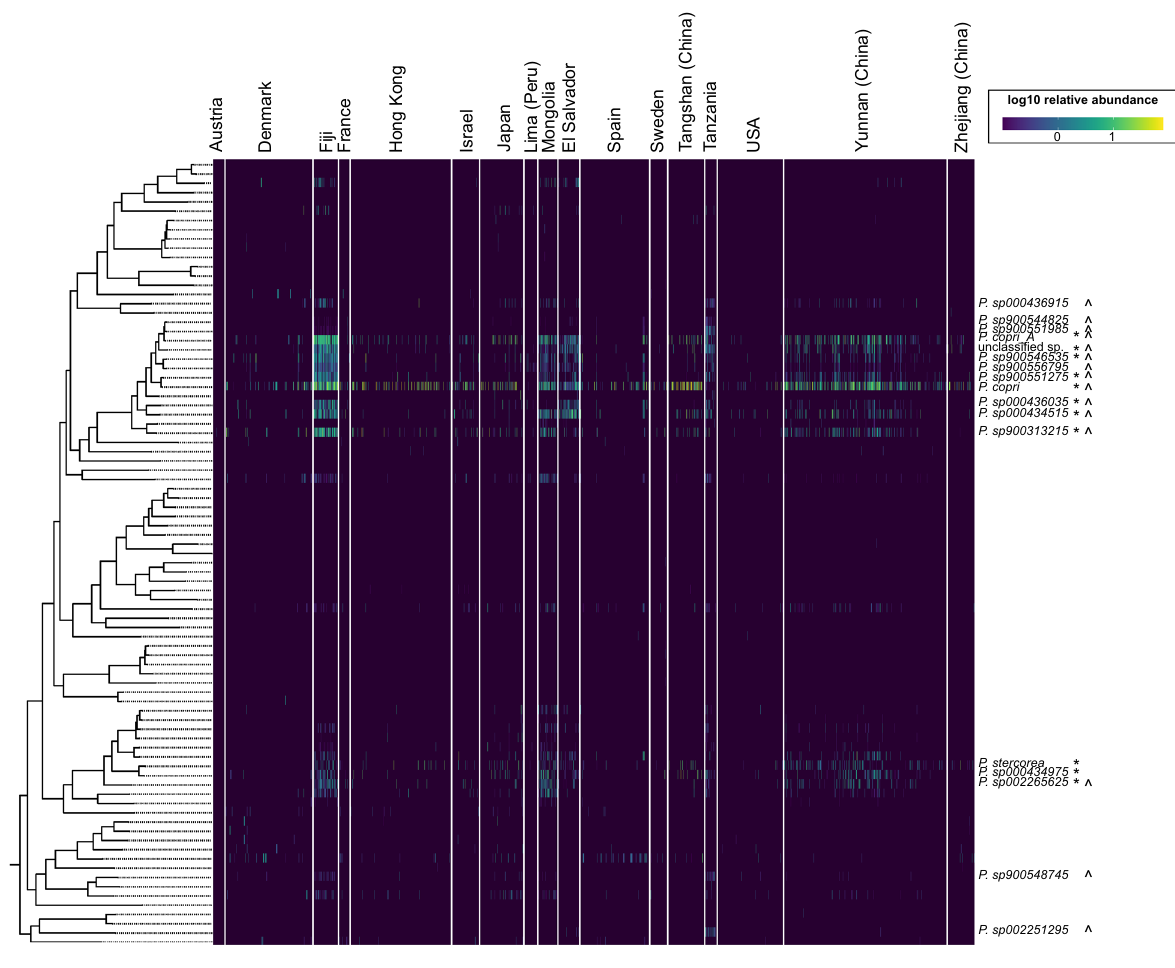
Figure 2. Estimated Prevotella relative abundances across several human gut metagenome data sets. Phylogenetic tree indicates relationships of the Prevotella genomes dereplicated at the species level (> 95% average nucleotide identity). Only genomes with reads mapped are included in this figure. Taxonomy labels are shown for species with at least 1% relative abundance (indicated with *) or at least 50% prevalence (indicated with ^) in any one data set. See Table S4 for relative abundance and prevalence